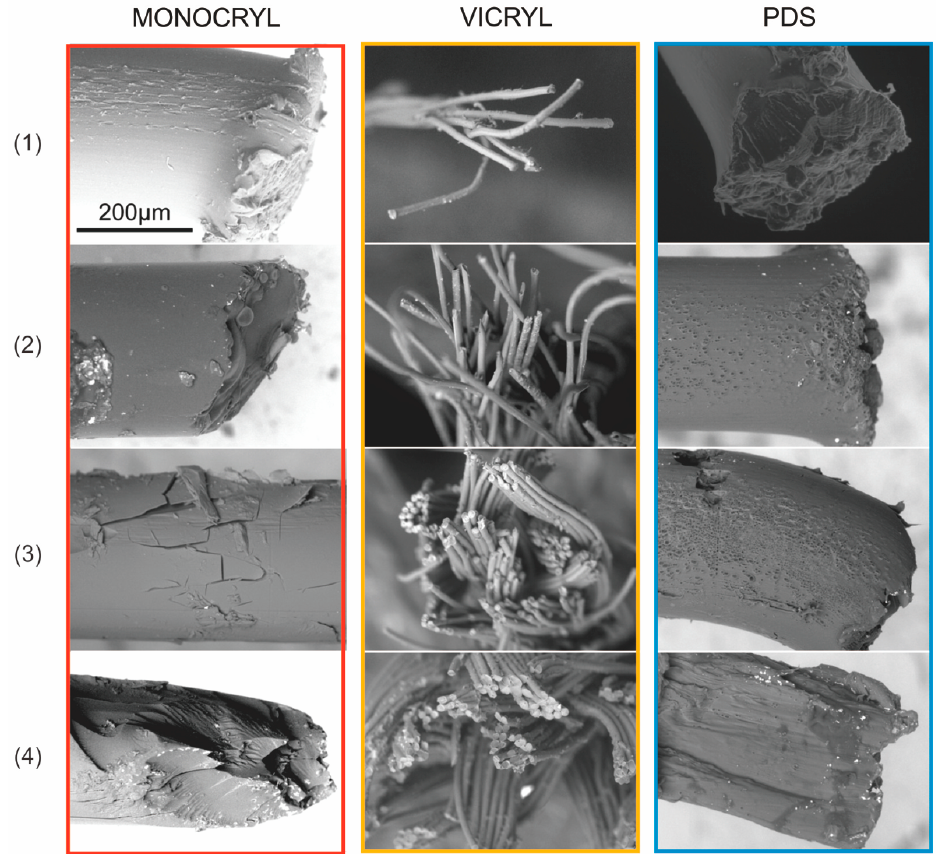
Figure 6. Scanning electron microscope images of uncoated sutures on day 21 (for Monocryl and Vicryl in sterile and infected pancreatic juice and bile) and day 28 of the experiment (for all sutures in a saline medium, PDS in all mediums): red box—Monocryl suture; orange box—Vicryl suture; blue box—PDS suture: ( 1) reference SEM images for the starting sutures (no medium); (2) saline—sterile environment; (3) pancreatic juice—contaminated environment; (4) bile—contaminated environment.